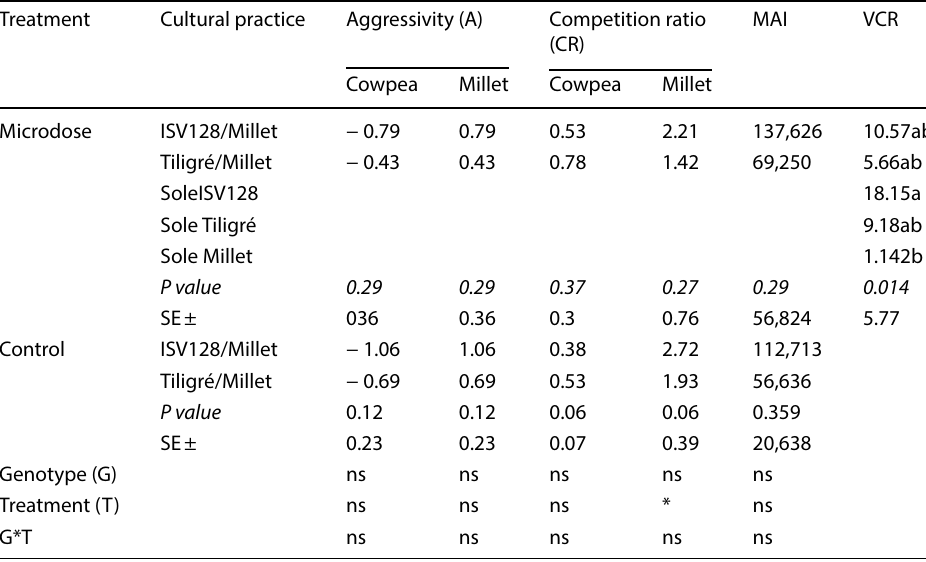
Table 5 Competition index of combined cowpea millet and economic advantage under microdose fertilizer and intercropping in combined crop and sole crop in 2020